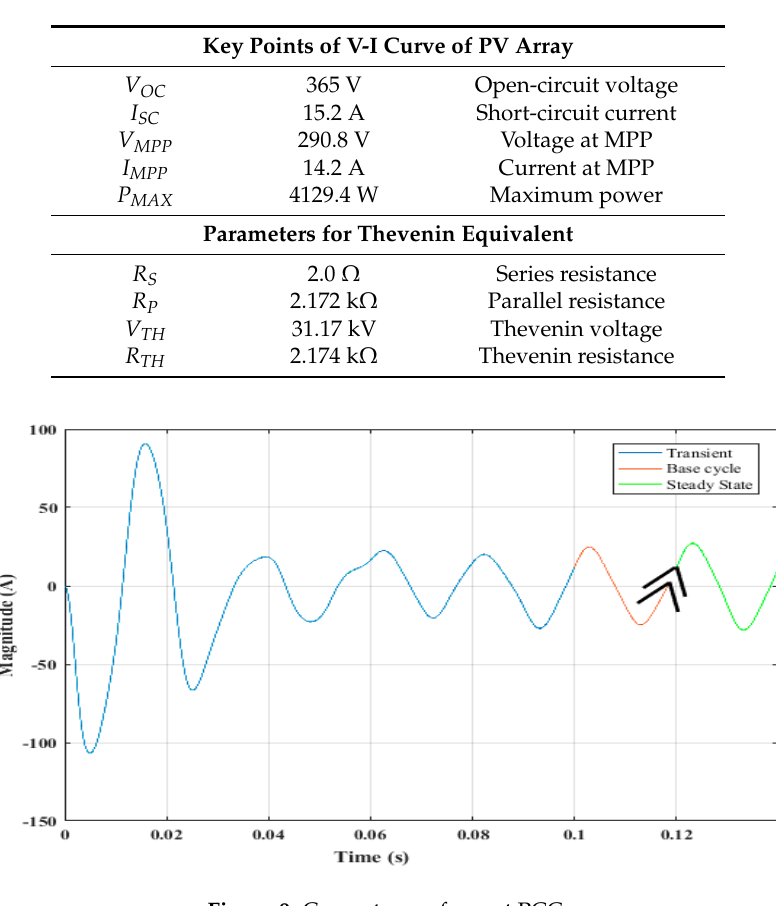
Figure 9. Current waveform at PCC.